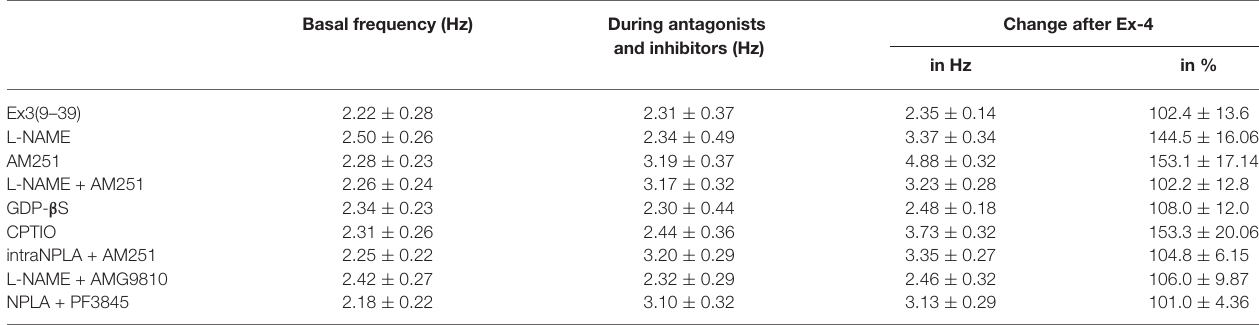
TABLE 4 | Changes in mPSC frequency upon application of Exendin-4 in the presence of various blockers. Basal frequency (Hz) During antagonists Change after Ex-4 and inhibitors (Hz) in